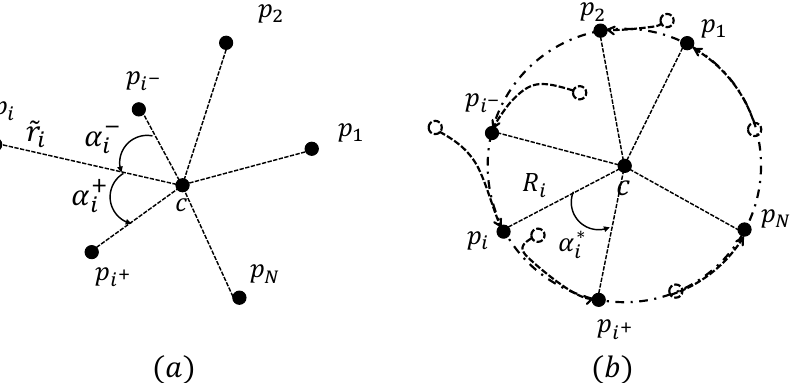
Figure 1. Formation of N robots on a plane. ( a ) Robots initially locate on a plane. ( b ) Robots form a predetermined formation around the